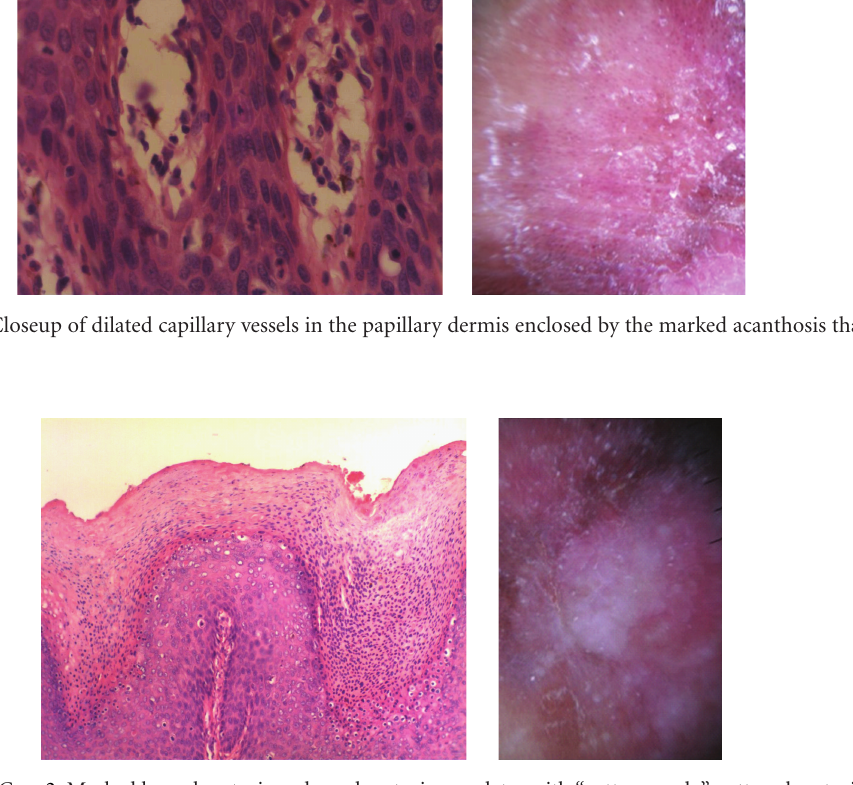
Figure 16: Case 2. Marked hyperkeratosis and parakeratosis correlates with “cotton candy” pattern